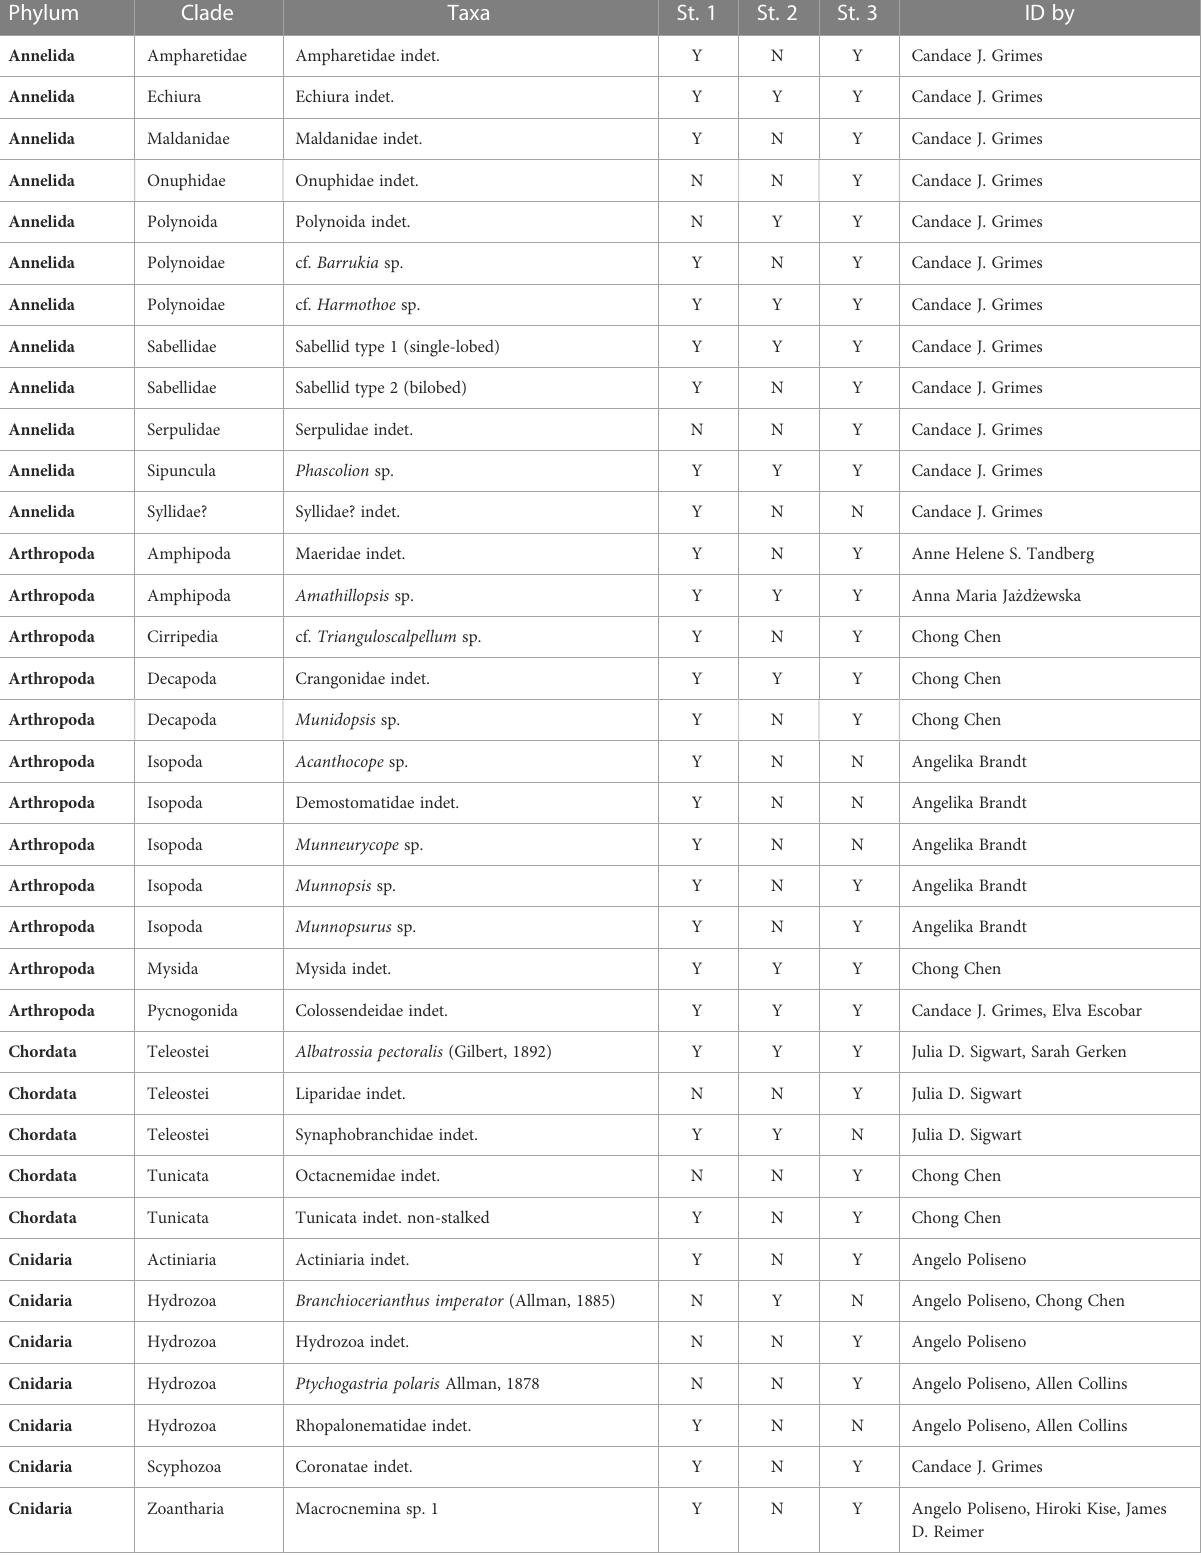
TABLE 1 Sightings of animals from still images taken in the 3 Bering Sea OFOS stations during the “ AleutBio ”